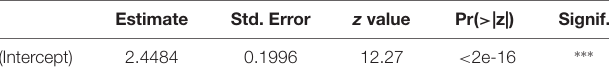
TABLE 3 | Parameter estimate, its standard error, z test statistic value and associated p -value for the precision parameter in the beta GLM model for the time fraction PEAP data.